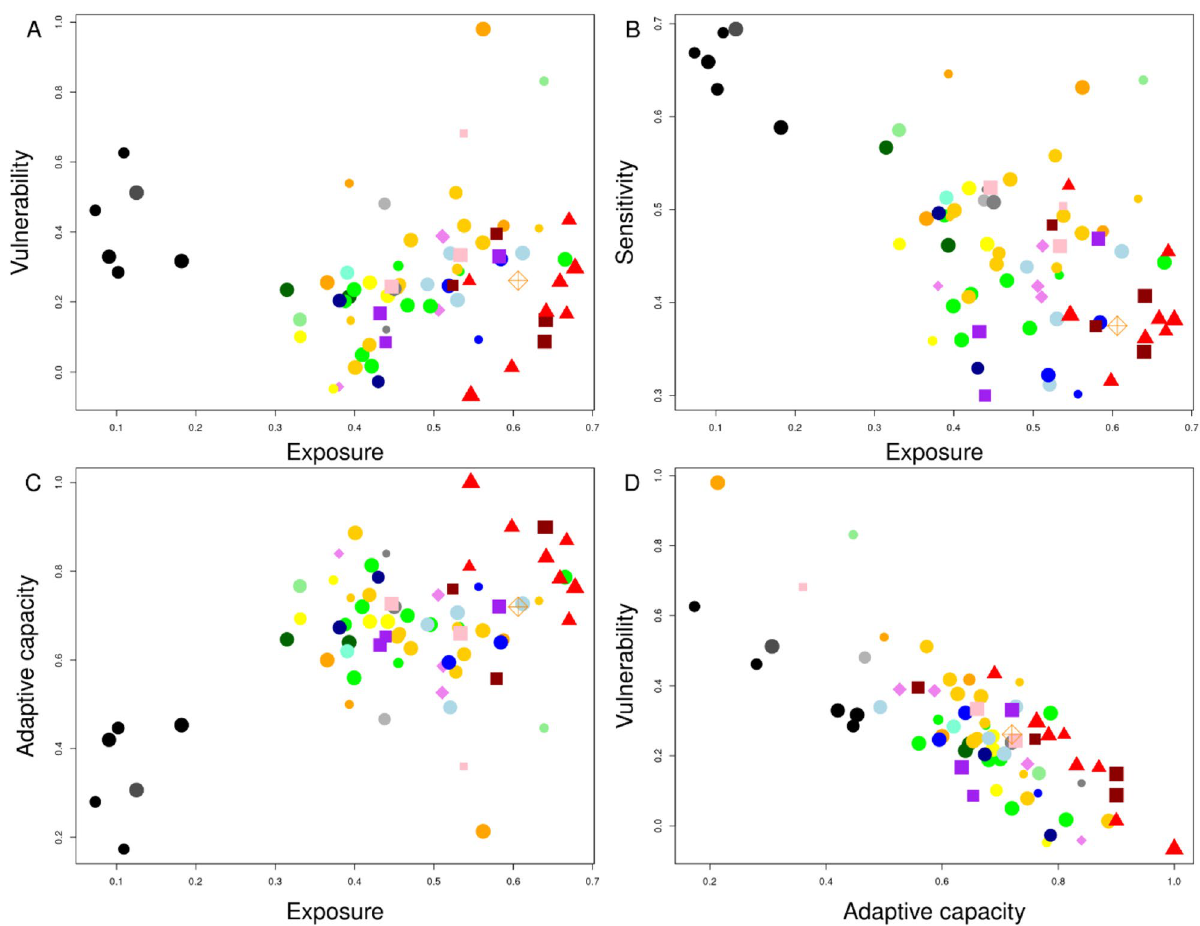
Figure 6. Relationship between species exposure and ( A ) vulnerability, ( B ) sensitivity and ( C ) adaptive capacity for the analysis carried out in the North region under climate change scenario RCP 8.5. Panel ( D ) shows the relationship between the adaptive capacity and the overall vulnerability for the species under study. The size of the points represents the confidence of the vulnerability assessment obtained during the bootstrap analysis. Colour and symbol legend as in Fig.